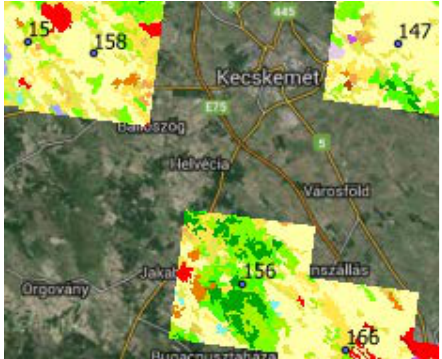
Figure 4. Some extracted worlds (from CORINE) with identifiers, GoogleMaps layer in background, scale 1:800 000, near the city of Kecskemét